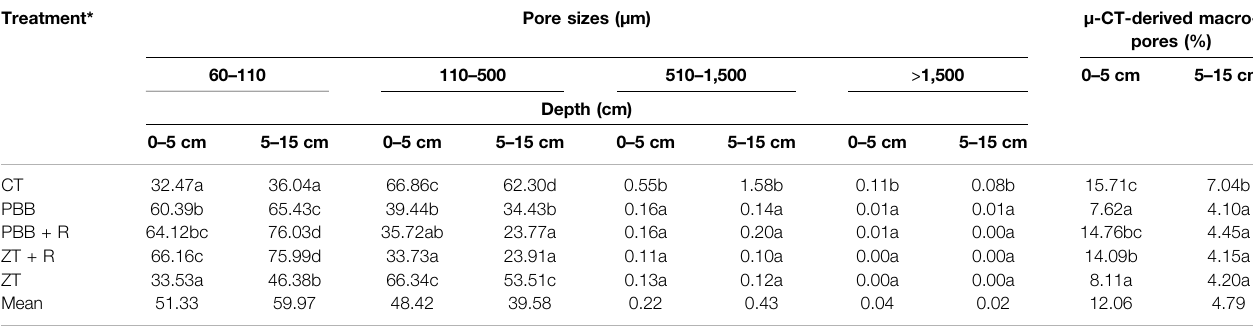
TABLE 1 | Percentage of the number of pores > 60 µm in each size range for 0 – 5 cm and 5 – 15 cm depths under different treatments.